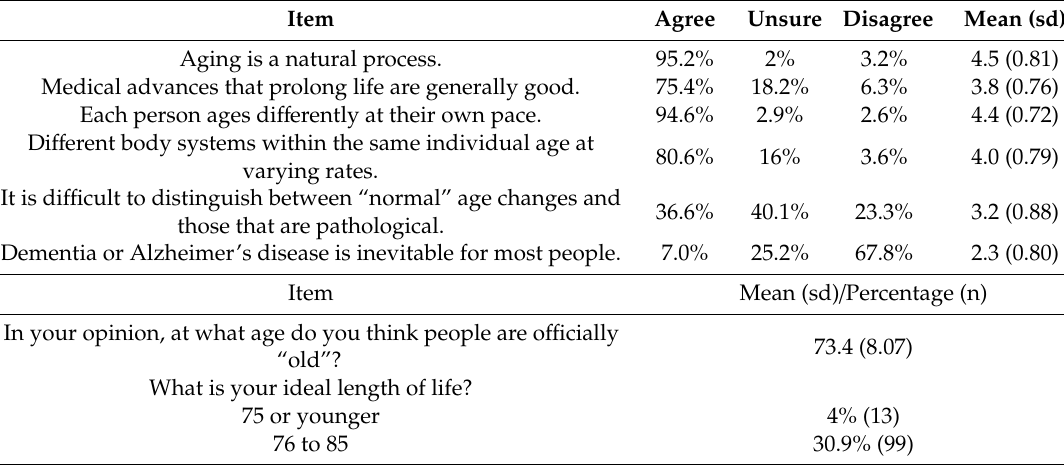
Table 2. Descriptive statistics on beliefs about aging ( n = 314)